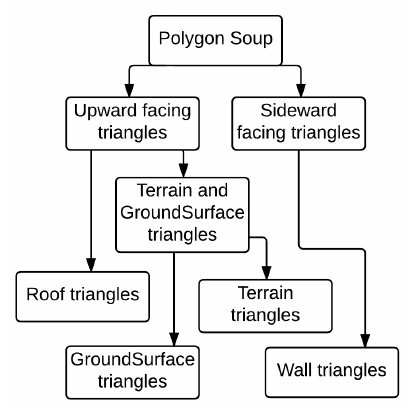
Figure 5: Decision tree of our method.